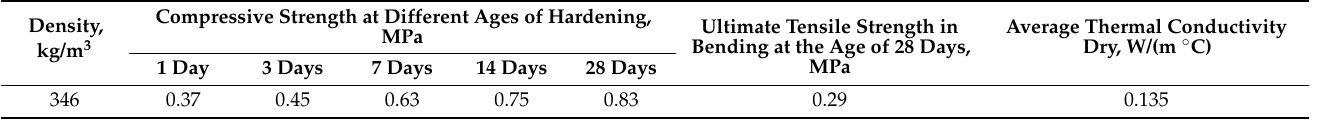
Table 3. The properties of polystyrene concrete.